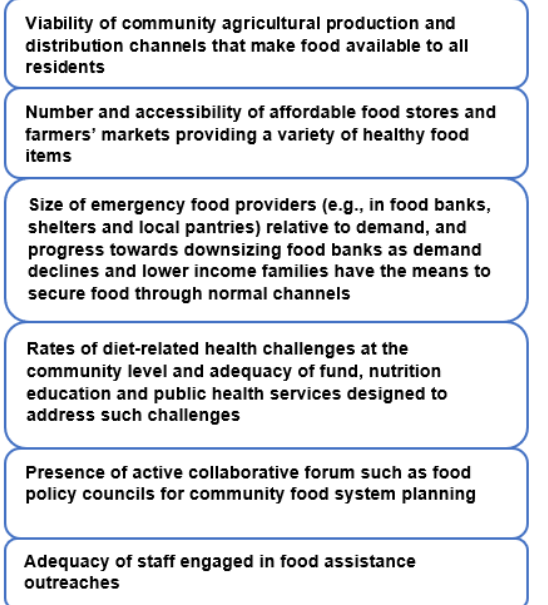
Figure 1. Six example metrics for determining what a food secure community looks like (compiled from [24]).